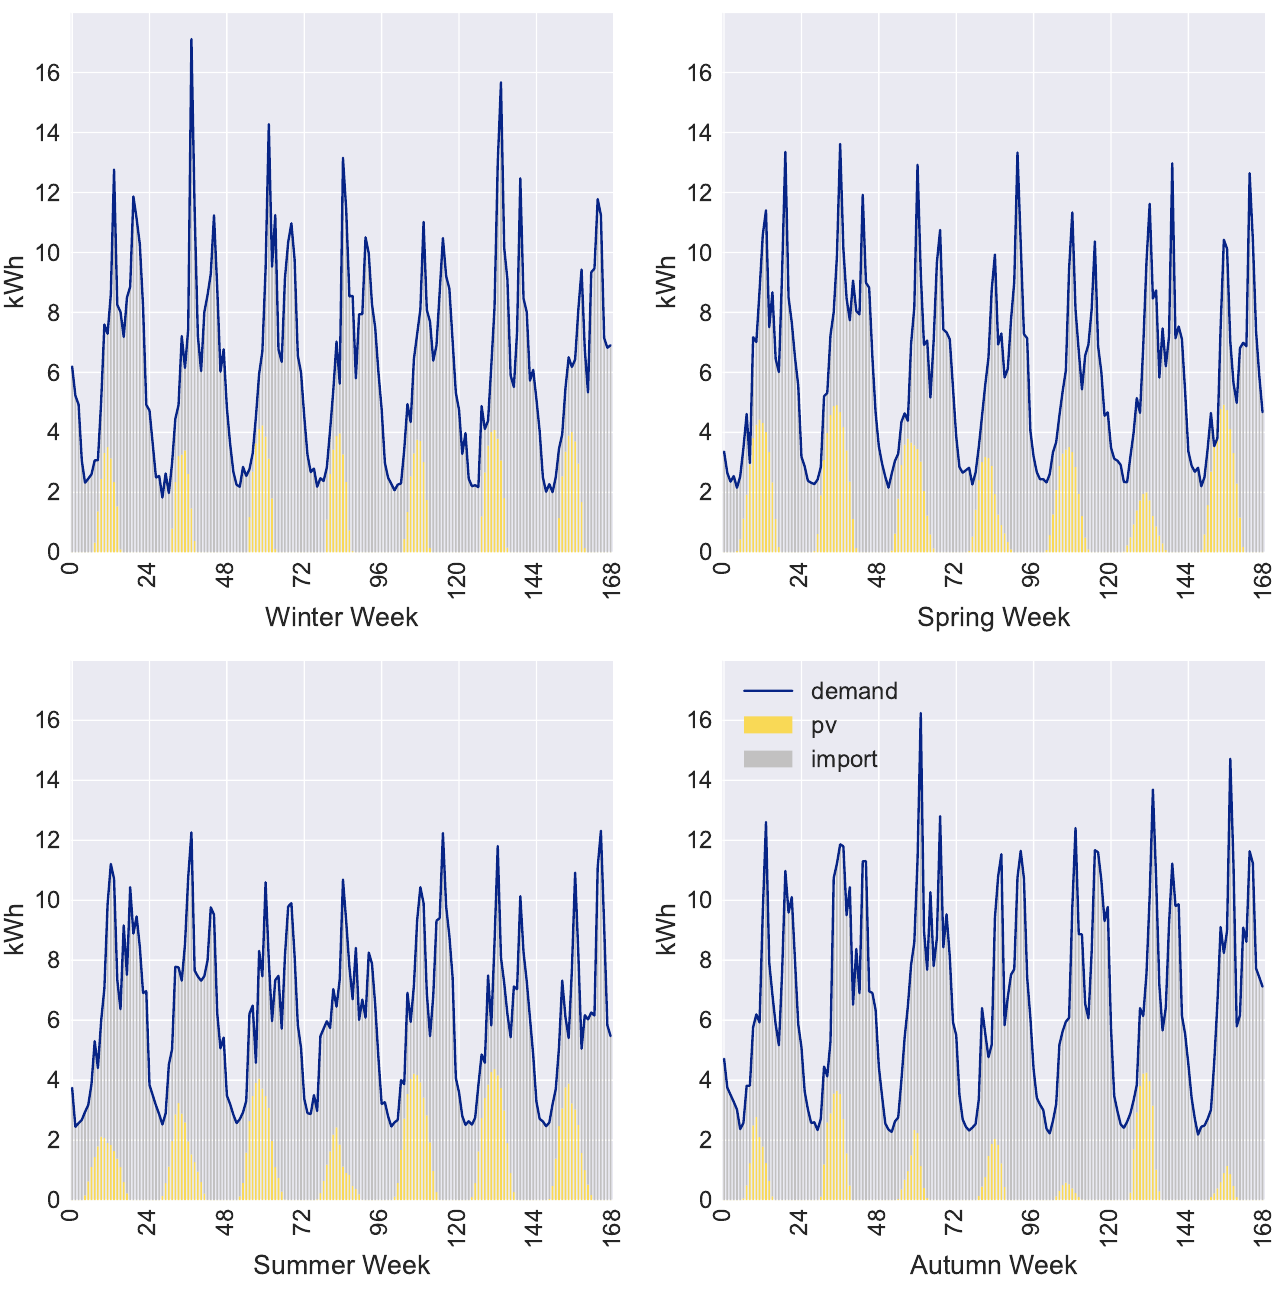
Figure A8. Weekly electricity production per technology source: Location